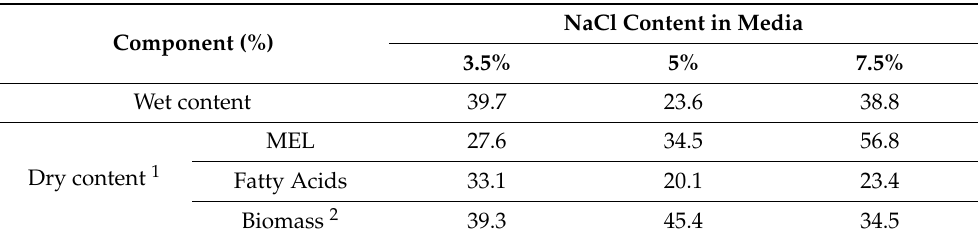
Table 1. Composition of MEL beads collected from fermentation flasks of conditions with 3.5%, 5%, and 7.5% ( w / w ) NaCl content in the media, at day